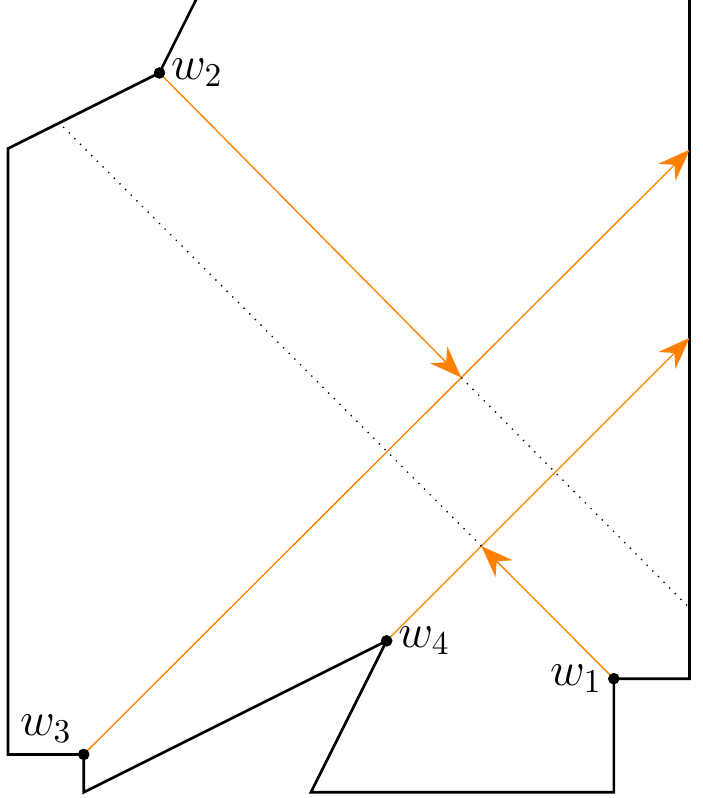
Figure 4. Insertion of m 4 makes m 1 crash. This activates m 3 which is now blocking m 2 . Theorem 1. The motorcycle insertion algorithm is